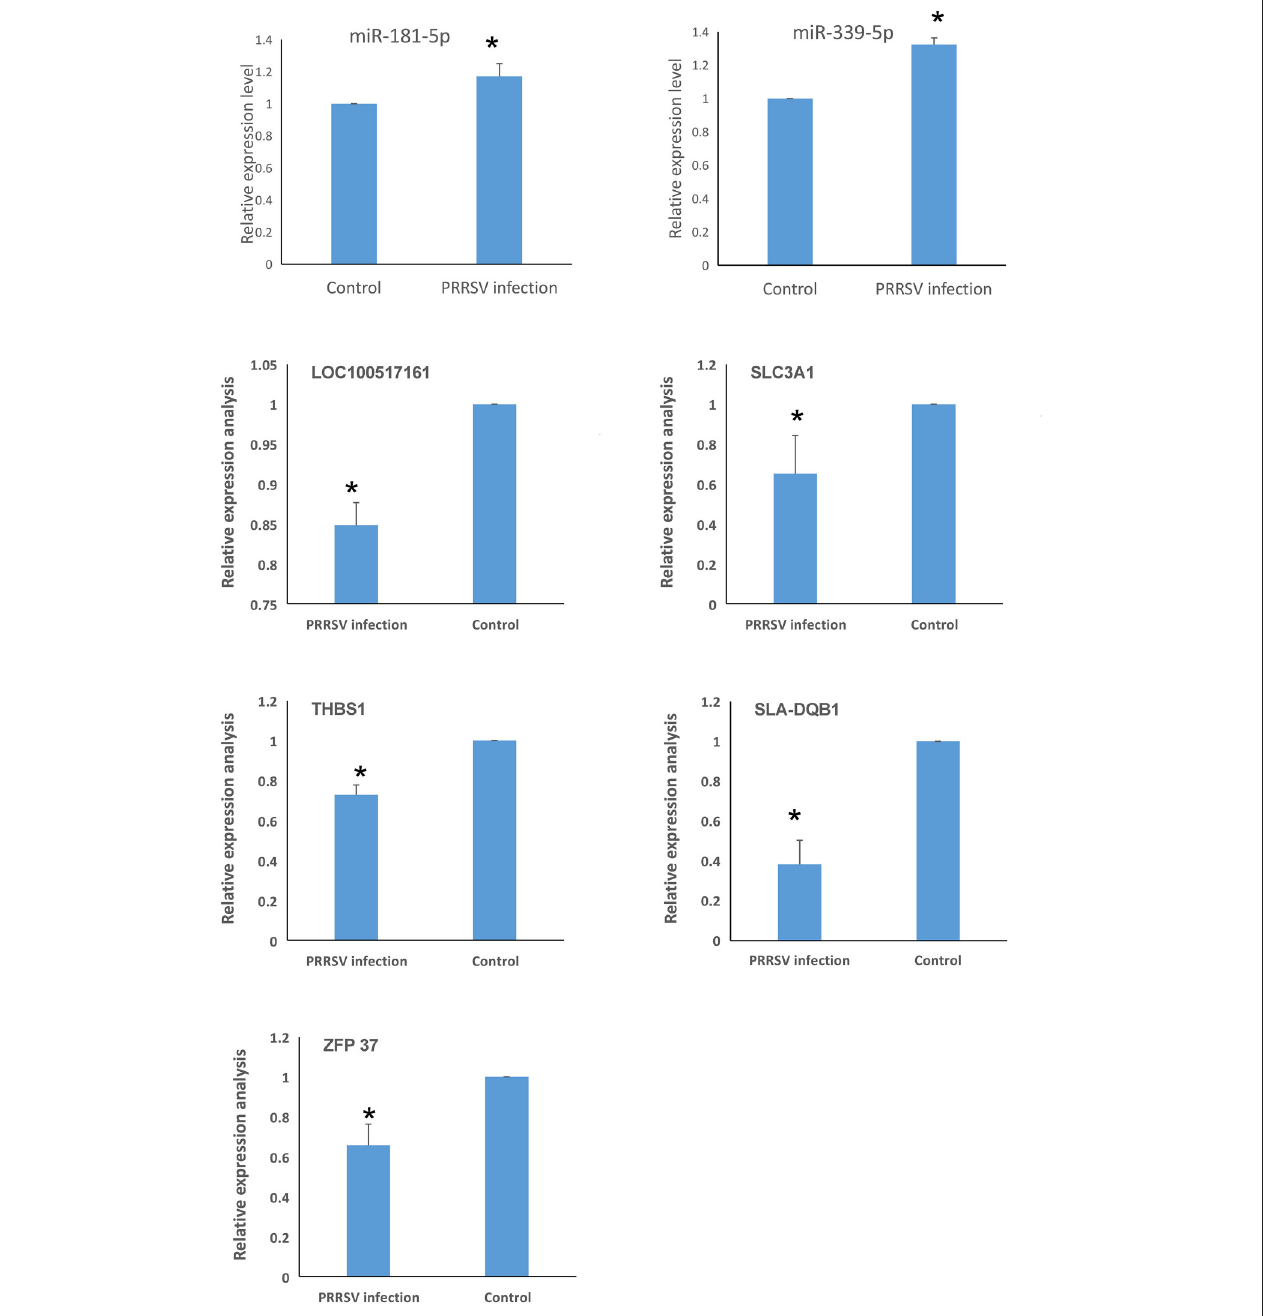
FIGURE 7 | Identification of genes related to PRRSV-induced apoptosis in PECs (* P < 0.05). miR-339-5p and miR-181-5p were significantly up-regulated in PRRSV-infected PECs compared to control cells. The expression of SLC3A1 , THBS1 , SLA-DQB1 , ZFP37 , and LOC100517161 were down-regulated in PRRSV-infected PECs compared to non-infected PECs (P <